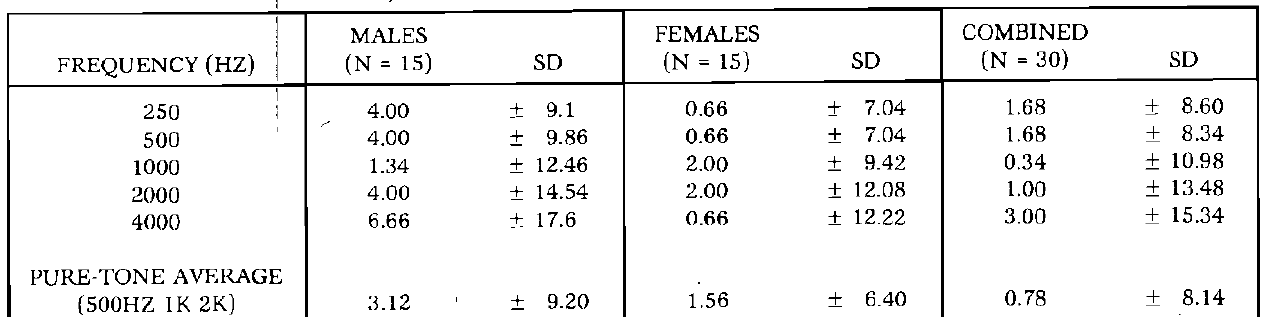
Table 2: Mean pure tone are also included